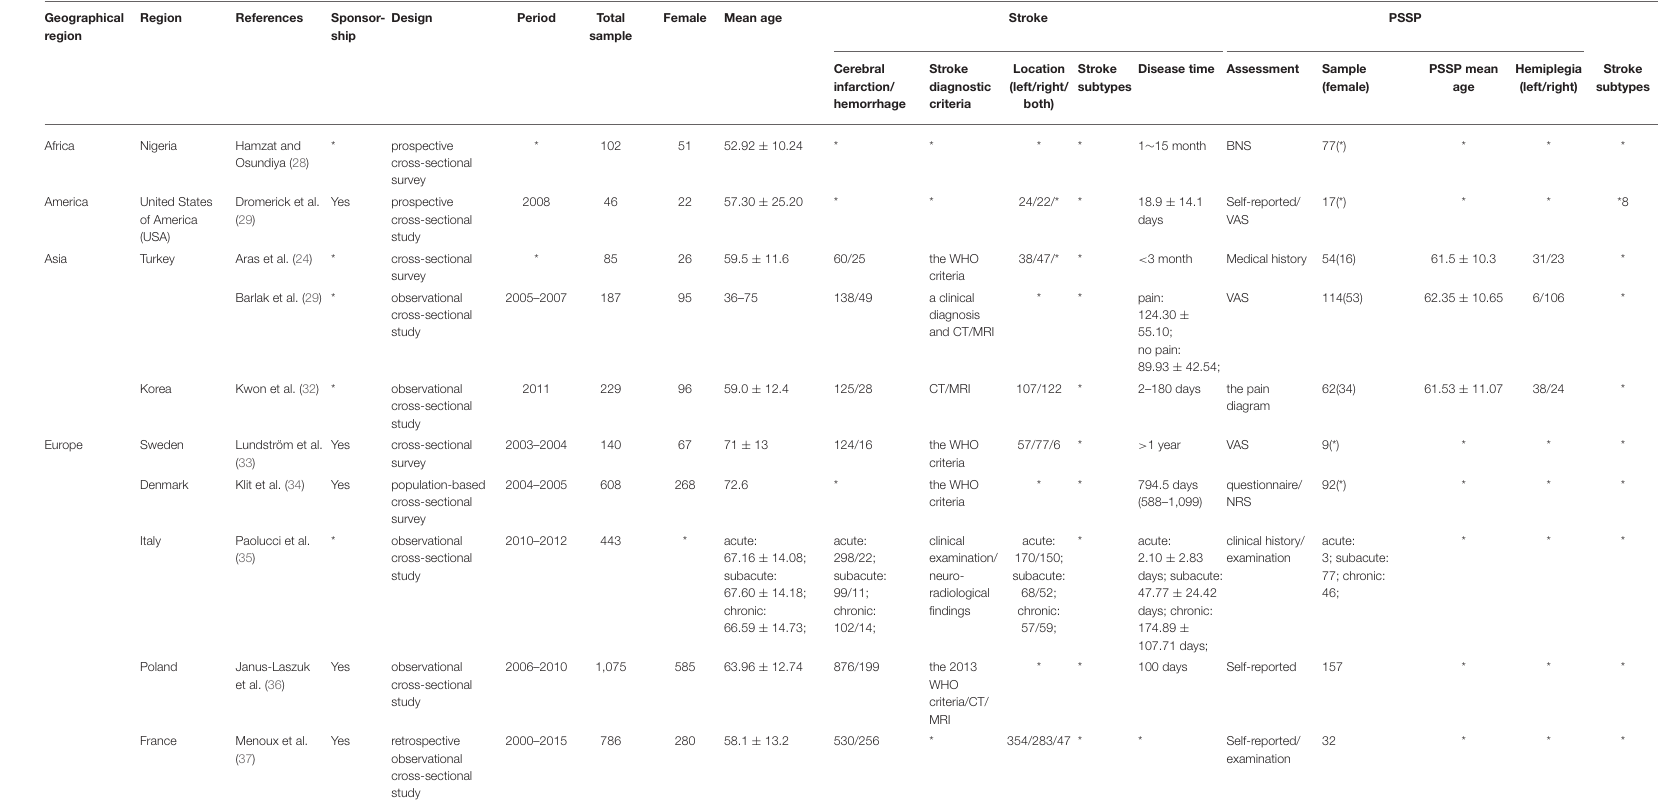
TABLE 4 | Characteristics of cross-sectional studies.